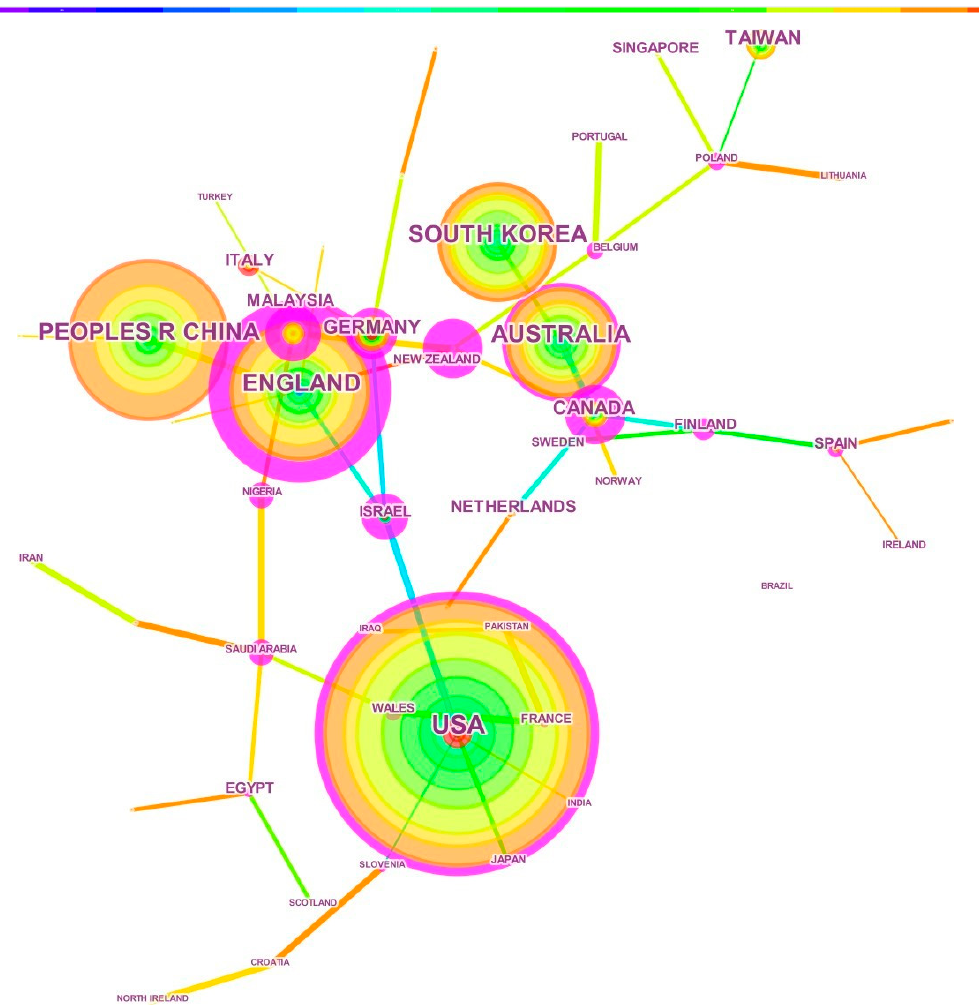
Figure 5. Network of countries/regions.